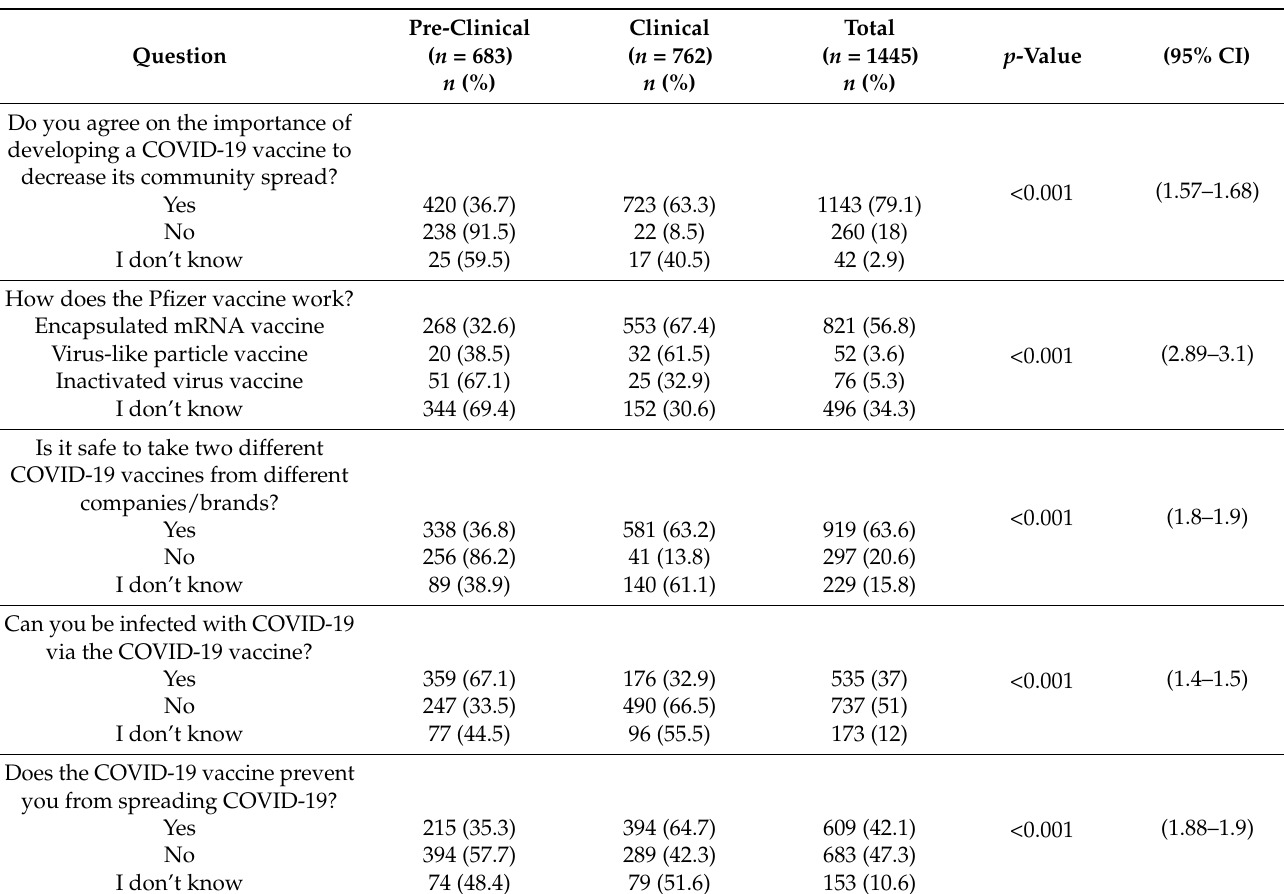
Table 2. Knowledge related to the COVID-19 vaccine and sources of information by pre- clinical/clinical